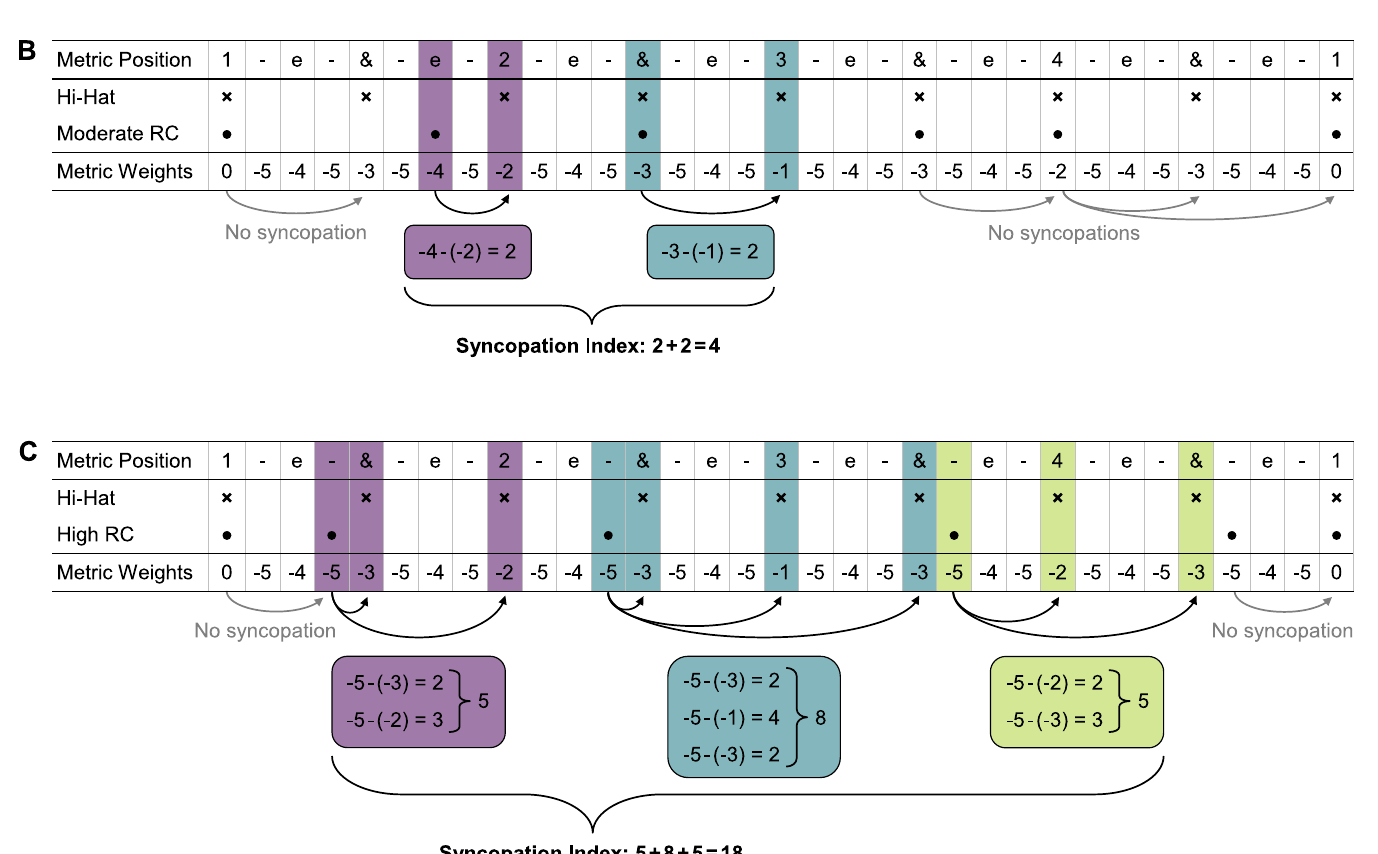
Fig 1. Description of the rhythms with metric weights and syncopation measures. A) Low, moderate and high rhythmic complexity (RC) stimuli. Each onset is represented by a dot ( ● ) with the corresponding metric weight noted below. The eight-note hi-hat ( × ) is part of each of the three stimuli. B and C) Calculations of the syncopation index following Fitch and Rosenfeld (2007) and Matthews et al. (2019) for the moderate and high rhythmic complexity stimuli. A syncopation occurs when a rest (here at the eight-note level) is preceded by the onset of a note of lesser weight. The summed up differences between syncopated notes and rests make the syncopation